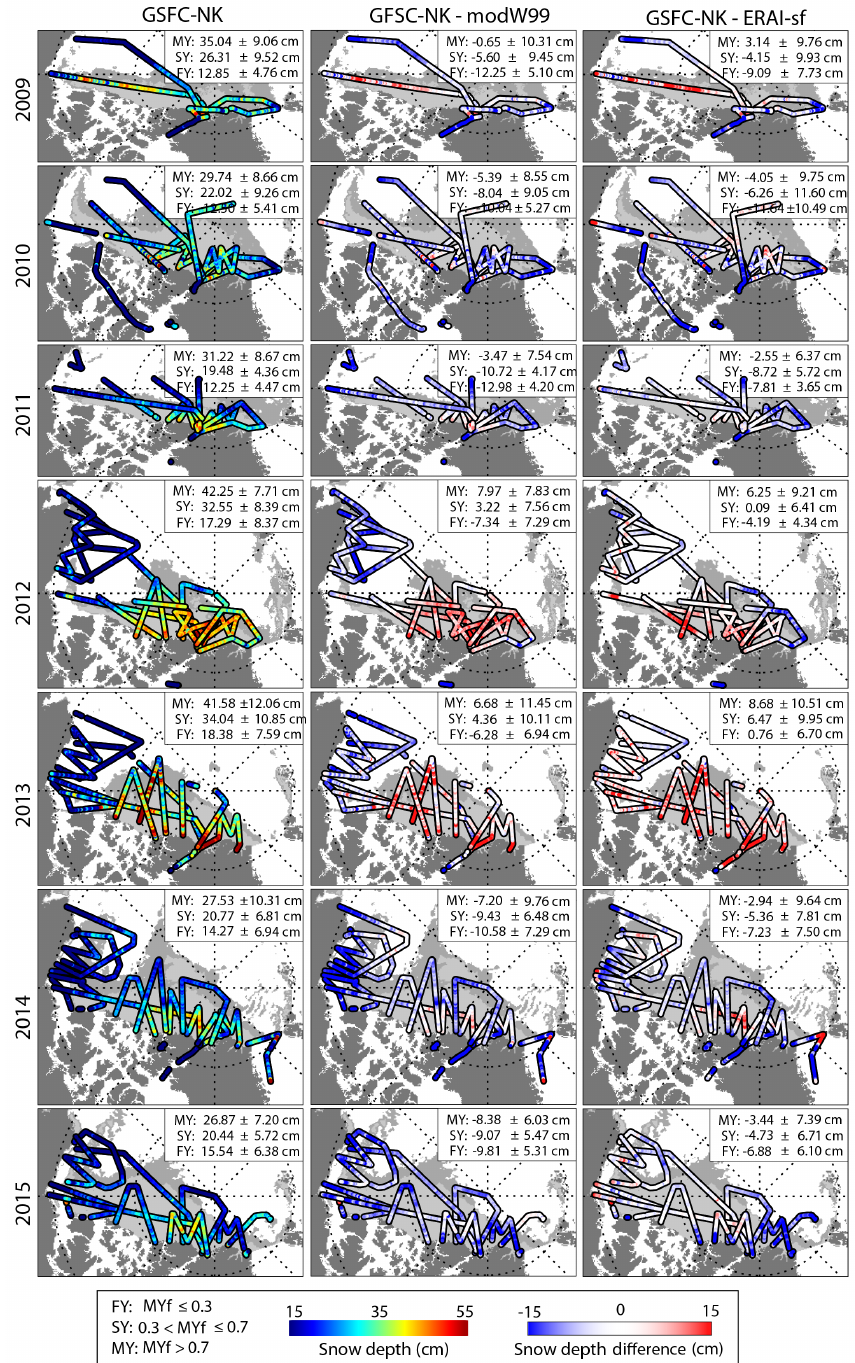
Figure 13. Comparison of GSFC-NK snow depth retrievals with ERAI-sf and